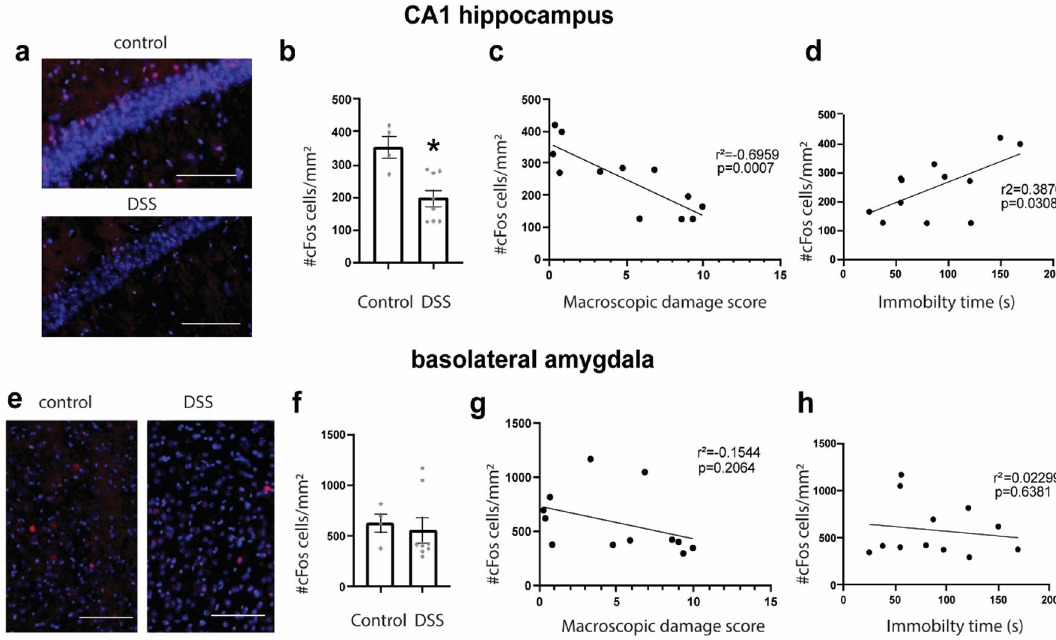
Figure 5. cFos expression in the CA1 hippocampus and the basolateral amygdala. ( a ) Representative image of cFos expression of control and DSS-treated animals in the CA1 of the hippocampus. DAPI in blue, cFos in red. Scale bar 100 µm. ( b ) Density of cFos + cells in the CA1 of the hippocampus; student’s t-test; *p < 0.05. ( c ) Linear regression between cFos density in the CA1 and macroscopic damage score. ( d ) Linear regression between cFos expression in the CA1 and immobility time. ( e ) Representative image of cFos expression of control and DSS- treated animals in the BLA. DAPI in blue, cFos in red. Scale bar 100 µm. ( f ) Density of cFos + cells in the BLA. ( g ) Linear regression between cFos density in the BLA and macroscopic damage score. ( h ) Linear regression between cFos density in the BLA and immobility time Data are mean ± SEM Control (n = 4) and 2.5% DSS (n =